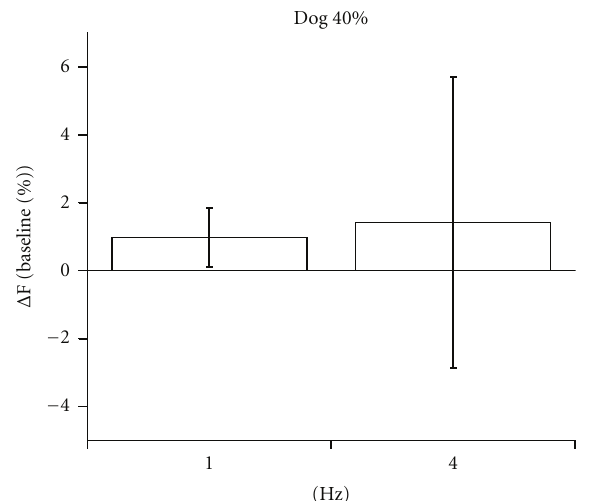
Figure 2: In dog trabeculae, at 40% variability, the average active developed force was not increased at 4 or 1 Hz. Results are expressed compared to baseline.